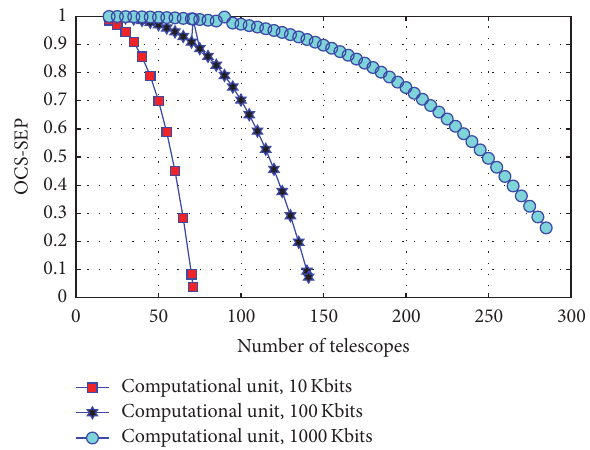
Figure 12: OCS-SEP for varying computational units and number of telescopes.